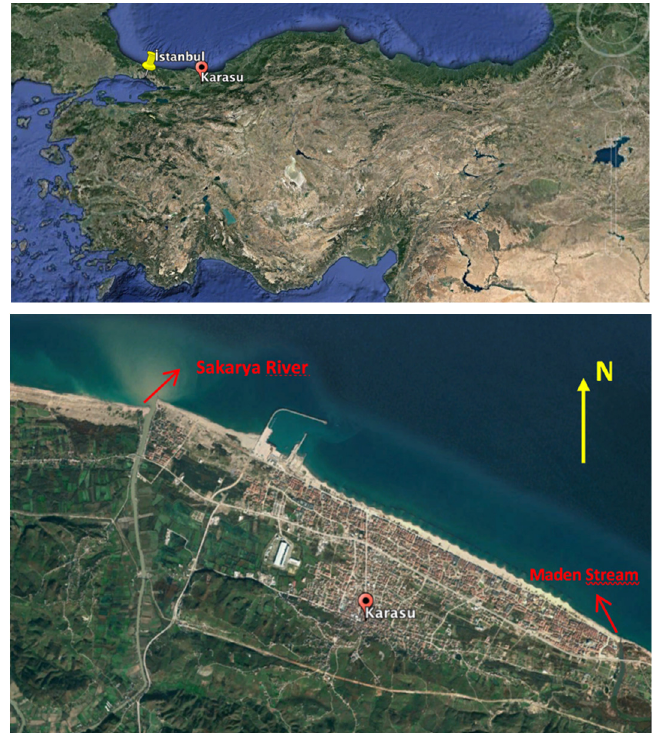
Figure 1. Location map of the study area (Google Map, 2018).